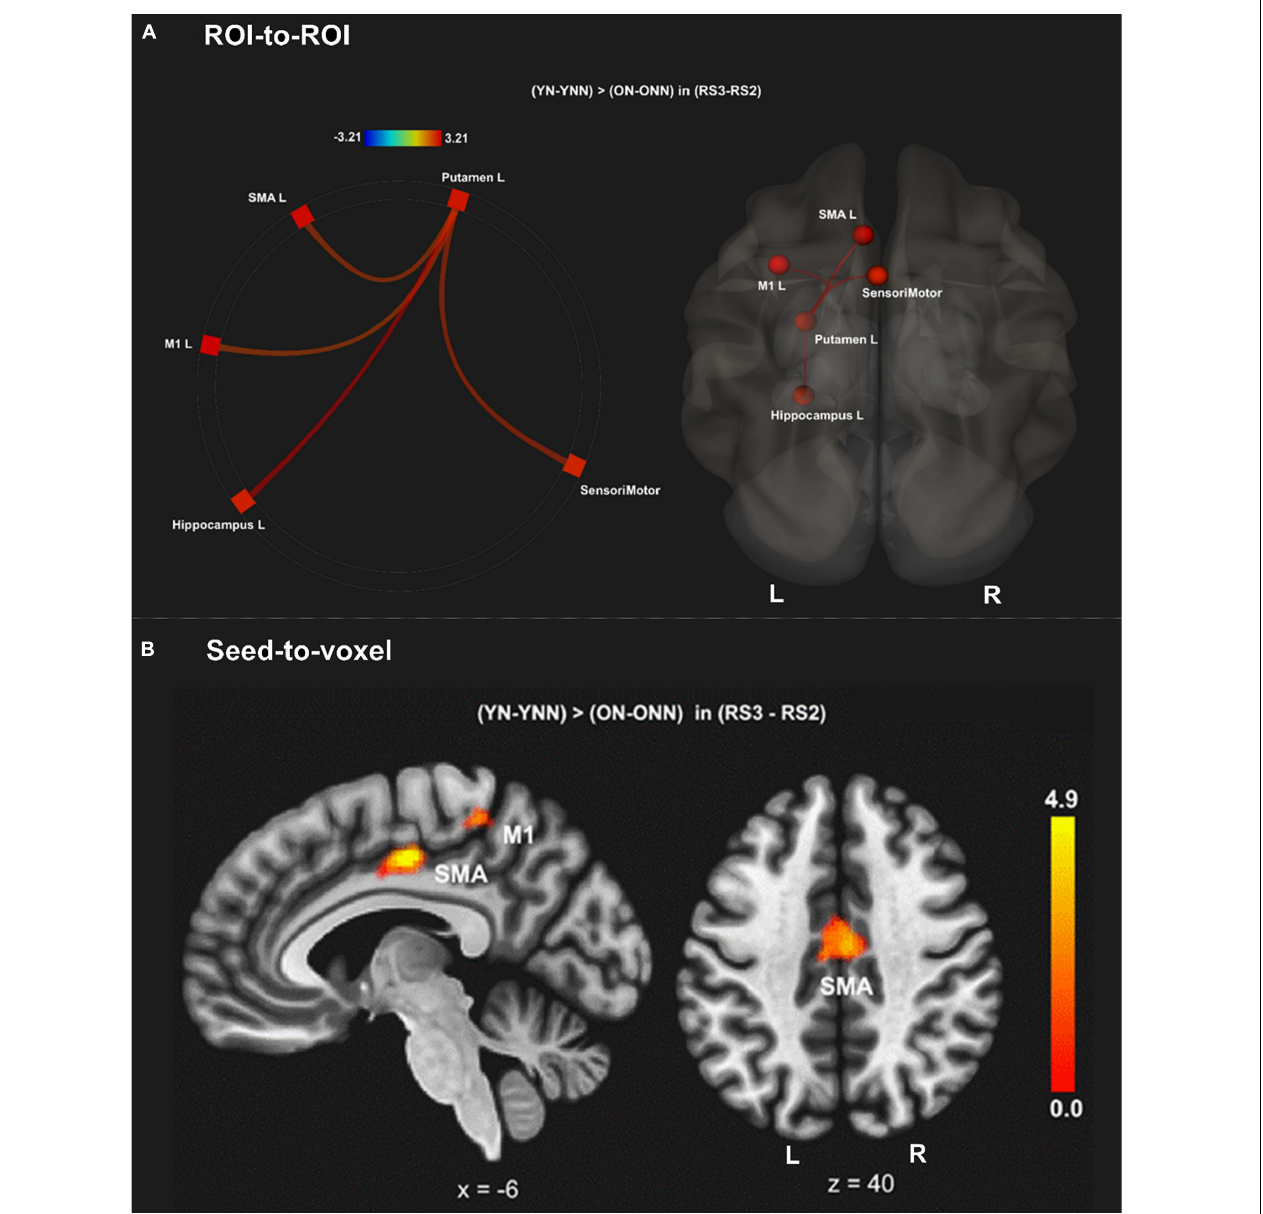
FIGURE 4 | (A) Region of interest-to-region of interest results of age × sleep interaction effects on post-MSL FC changes in the cortico-striatal–hippocampal regions from RS2 to RS3. (B) Seed-to-voxel results of age × sleep interaction effects on post-MSL FC changes between putamen and motor cortex from RS2 to RS3. The differences between YN and YNN in the FC changes were greater than that between ON and ONN. YN, Young Nap; YNN, Young No Nap; ON, Older Nap; ONN, Older No Nap.